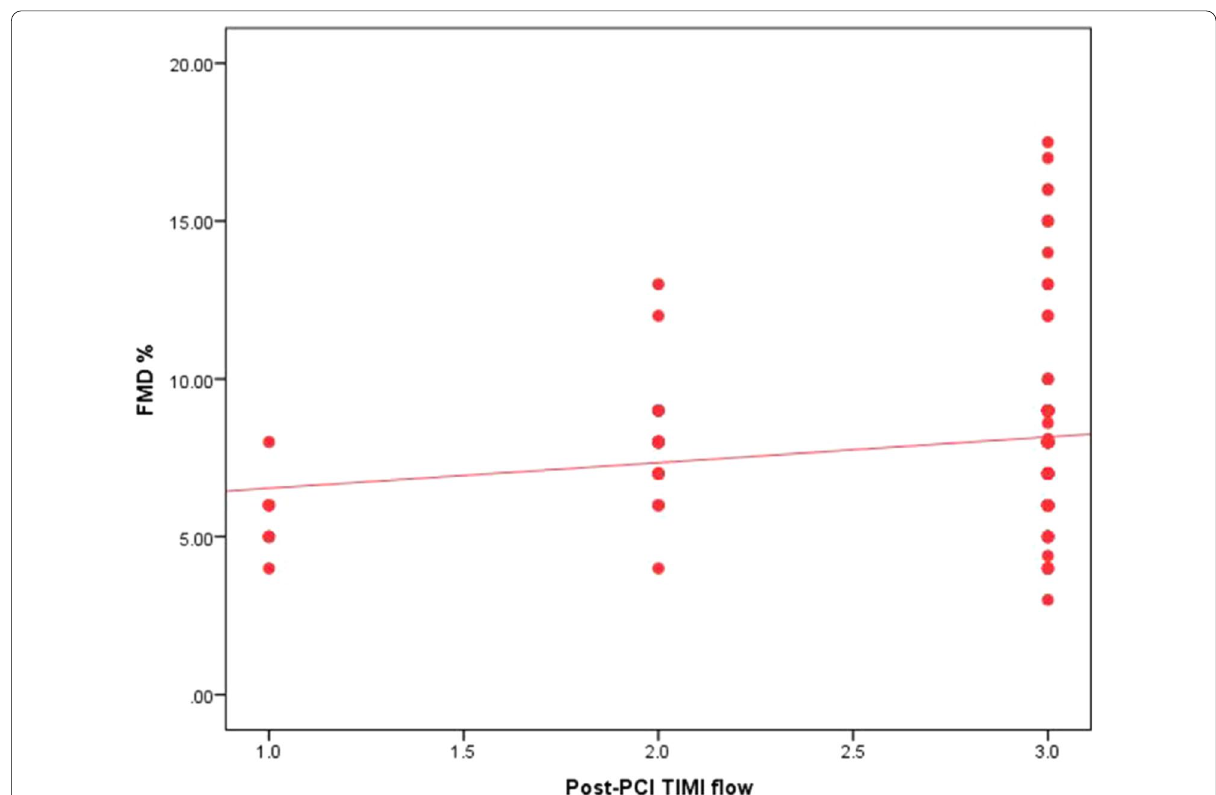
Fig. 2 Correlation between FMD and TIMI